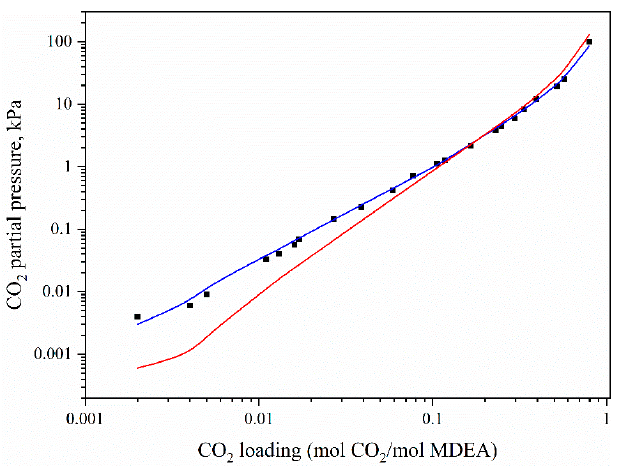
Figure 6. Comparison of the calculated data in the reference and in this work for the CO 2 –H 2 O– MDEA system. ■ , experimental data measured by Jou et al. [43]; —, data calculated with the reaction parameters proposed by Austgen et al. [36]; and —, data calculated in this work.